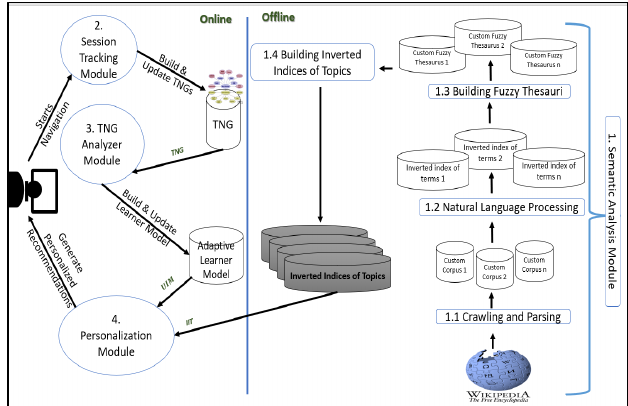
Fig. 1. Personalized content recommendation